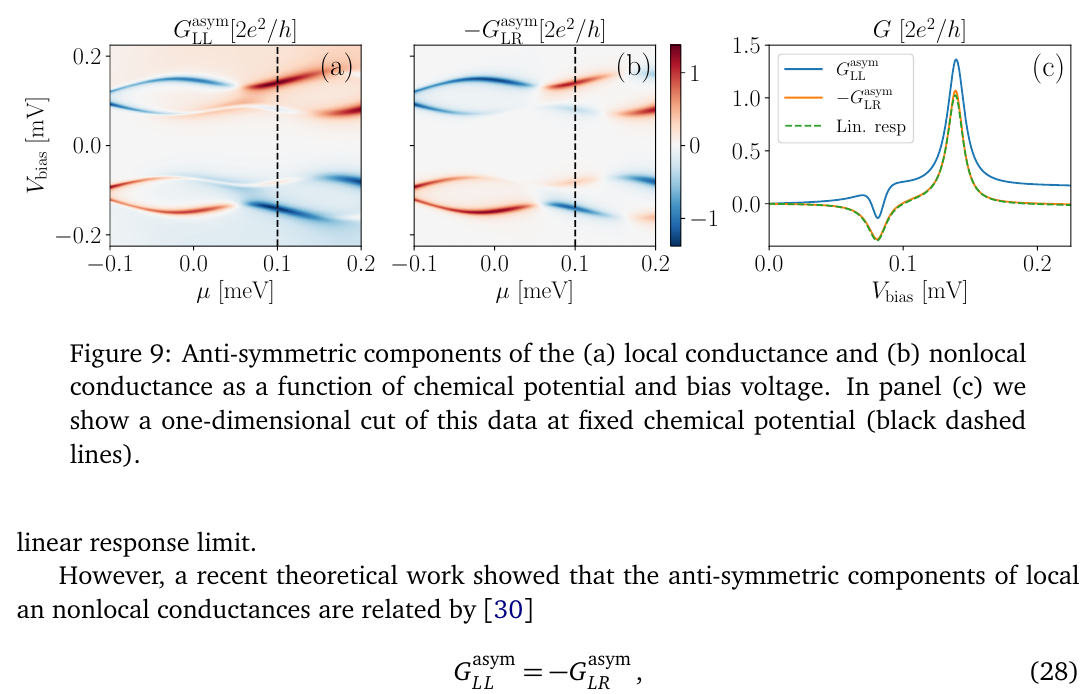
Figure 8: Schematic three-terminal superconducting device with bias dependent tun- nel barriers and quantum dots.